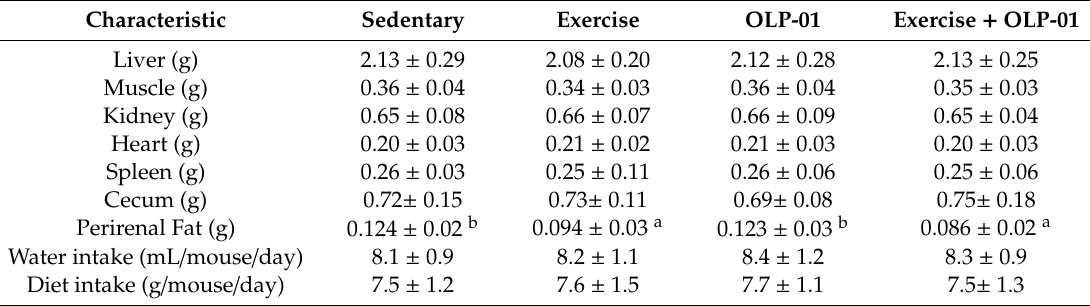
Table 1. Effects of exercise and probiotics on body composition and diet intake. Table 1. E ff ects of exercise and probiotics on body composition and diet